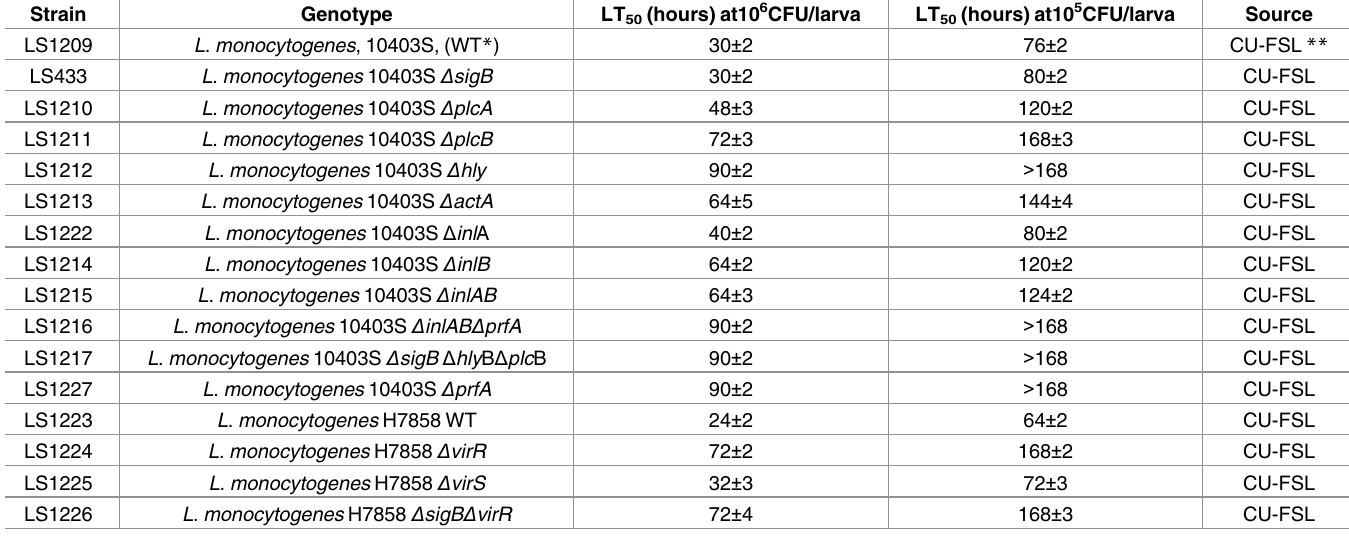
Table 3. LT 50 of G . mellonella larvae at 37˚C after inoculation with L . monocytogenes isogenic mutant